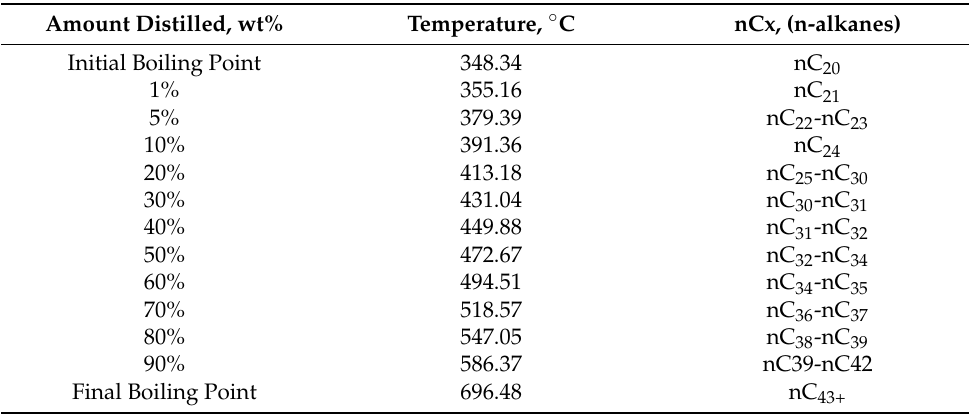
Table 2. SIMDIS data for FTS waxes used for